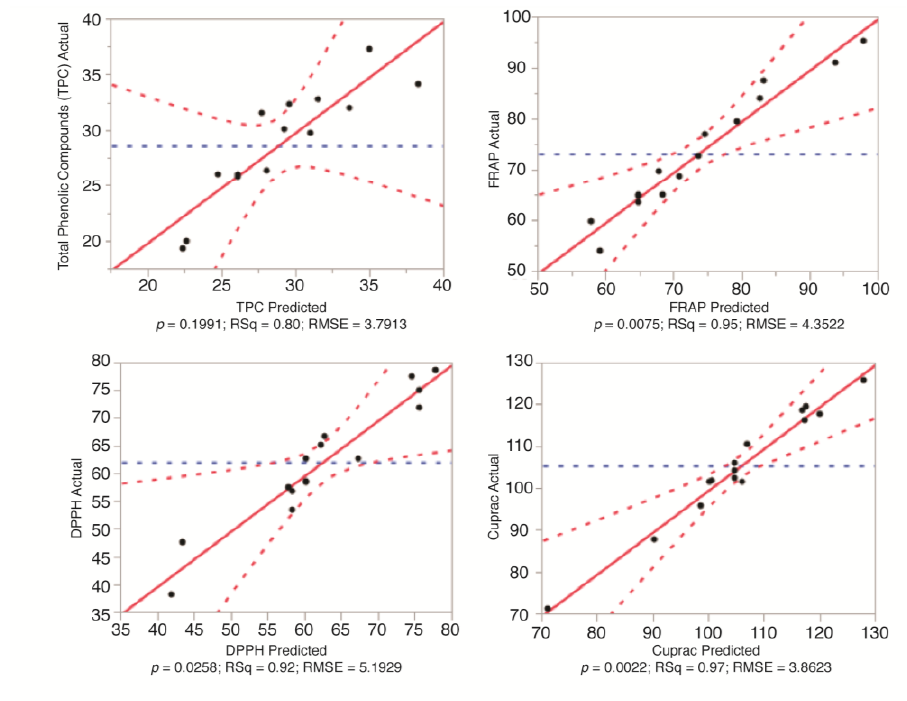
Figure 2. Correlation between the actual and the predicted values for the total phenolic compounds (TPC) and antioxidant capacity of olive leaf water extract (FRAP, DPPH and CUPRAC).